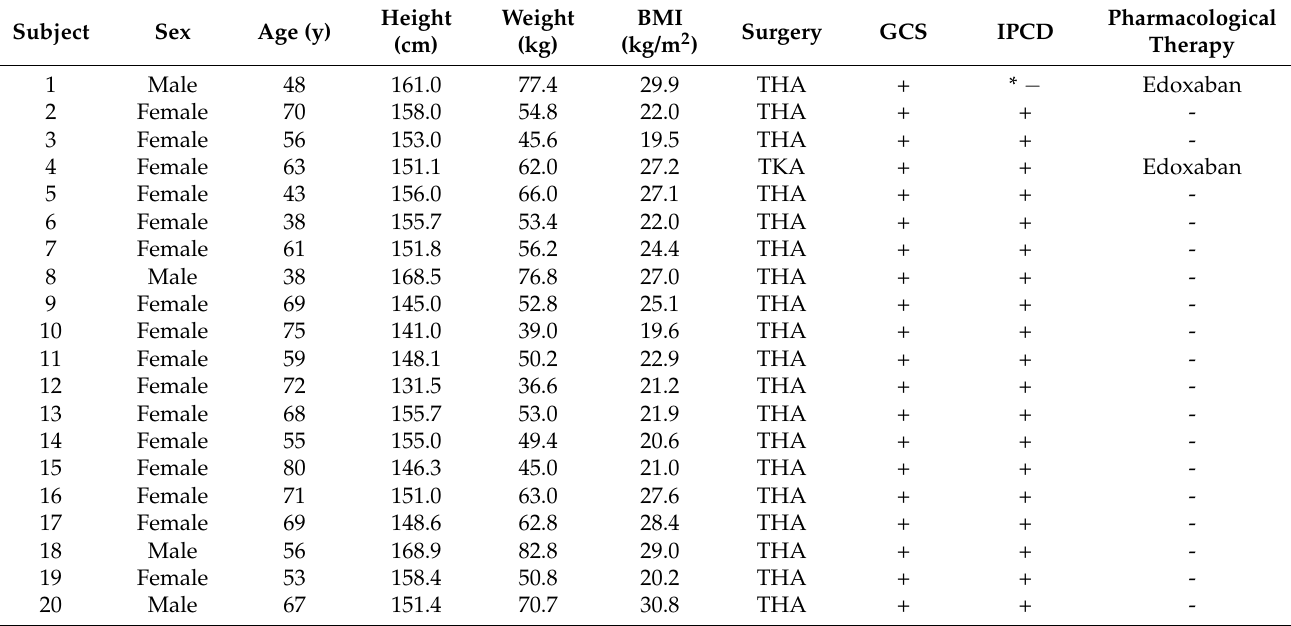
Table 1. Background of the subjects.